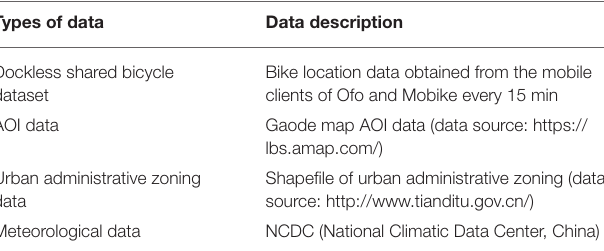
TABLE 1 | Data acquisition in the study area.